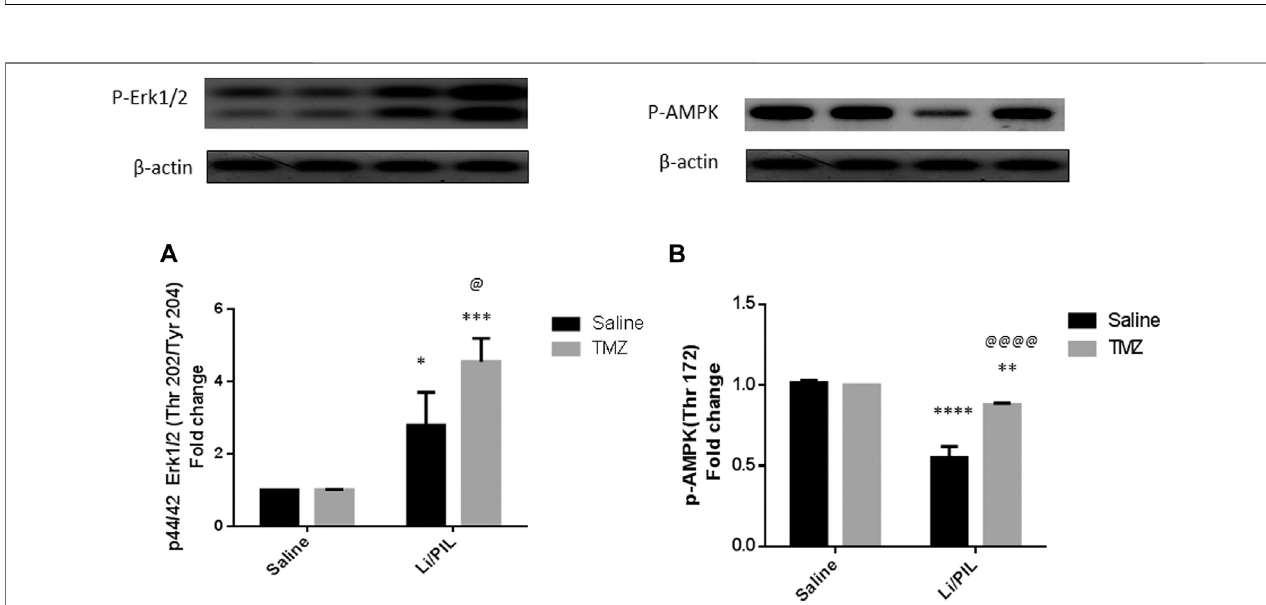
FIGURE 4 | Effect of TMZ on the protein expression of p-44/42 Erk1/2 (Thr202/Tyr204) and p -AMPK (Thy172) in the hippocampi of rats with Li/PIL-induced seizures. (A) The expression of p-44/42 Erk1/2 (Thr202/Tyr204) as indicated by Western blot analysis; (B) the expression of p -AMPK (Thy172) as indicated by Western blot analysis. Values are expressed as mean of three animals ± SD. Two-way ANOVA followed by the Tukey – Kramer post-hoc test was used for statistical analyses of data. *Signi fi cantly different from the normal control group (Saline) at p < 0.05; **Signi fi cantly different from the normal control group (Saline) at p < 0.01; ***Signi fi cantly different from the normal control group (Saline) at p < 0.001; ****Signi fi cantly different from the normal control group (Saline) at p < 0.0001; @ Signi fi cantly different from the Li/PIL control group at p < 0.05; @@@@ Signi fi cantly different from the Li/PIL control group at p <